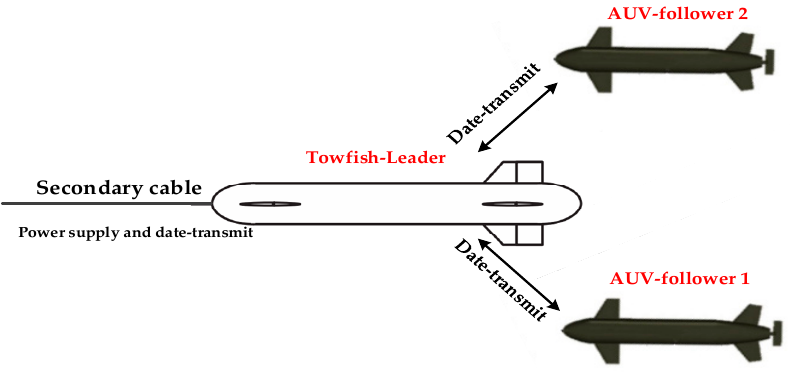
Figure 1. Joint formation of a towfish and two AUVs.